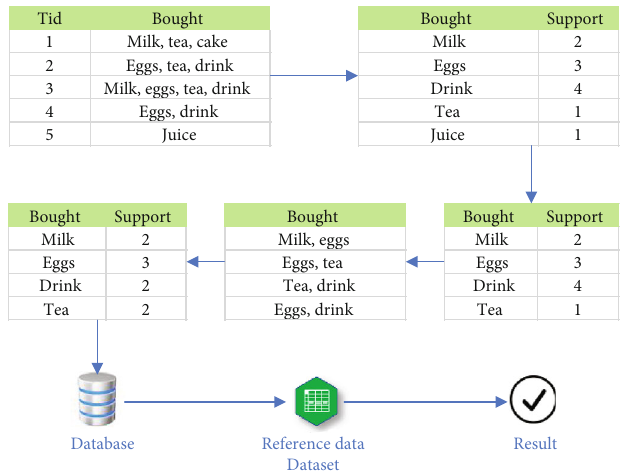
Figure 1: Flowchart of the improved Apriori